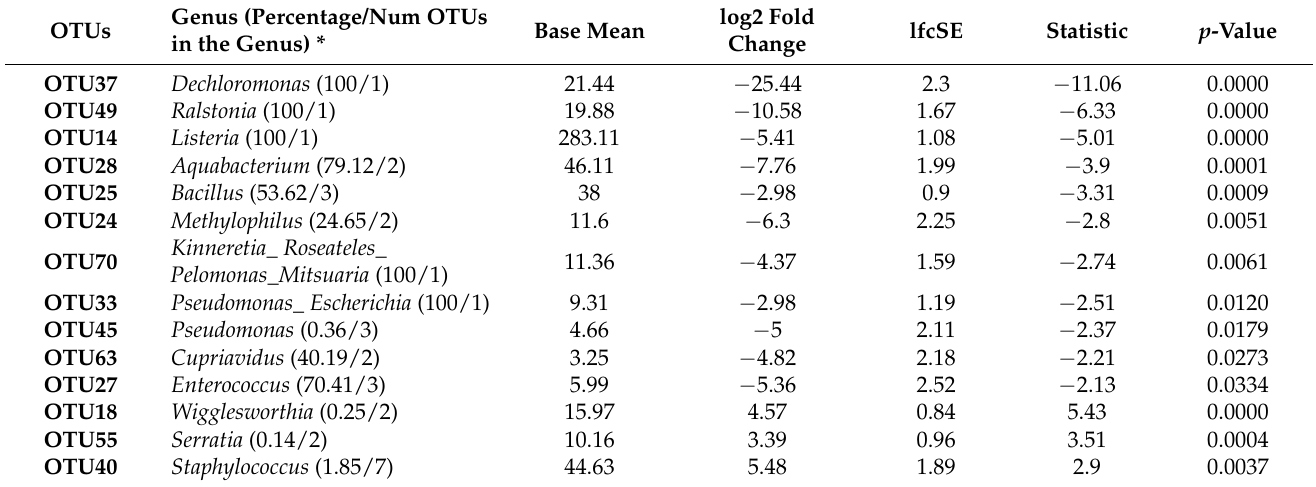
Table 2. Operational Taxonomic Units displaying a significant difference in abundance between tsetse flies with midguts non-infected vs. infected with trypanosomes.